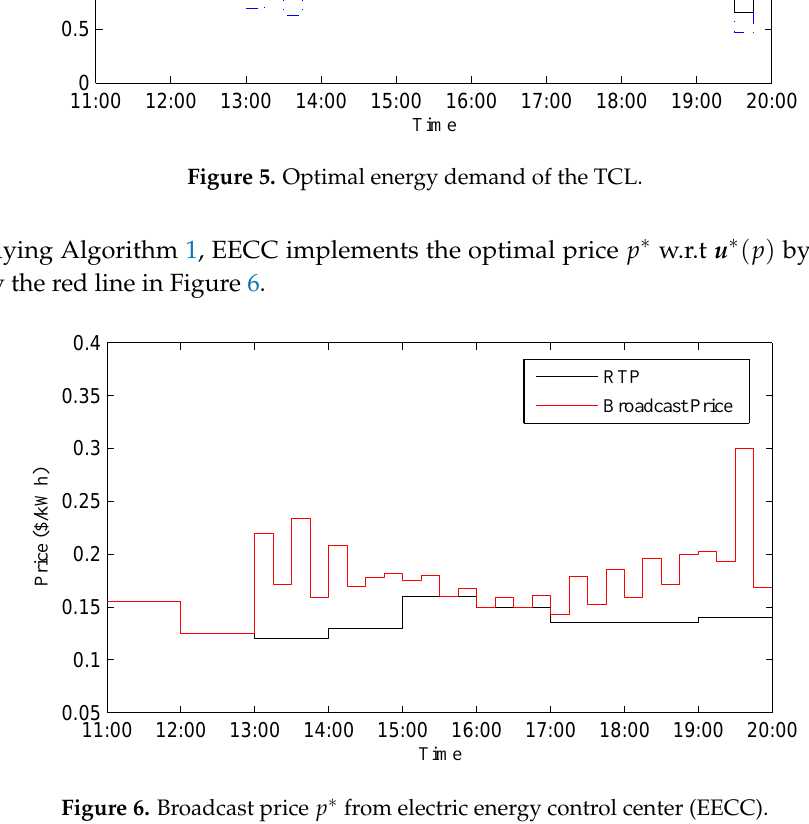
Figure 6. Broadcast price p ∗ from electric energy control center